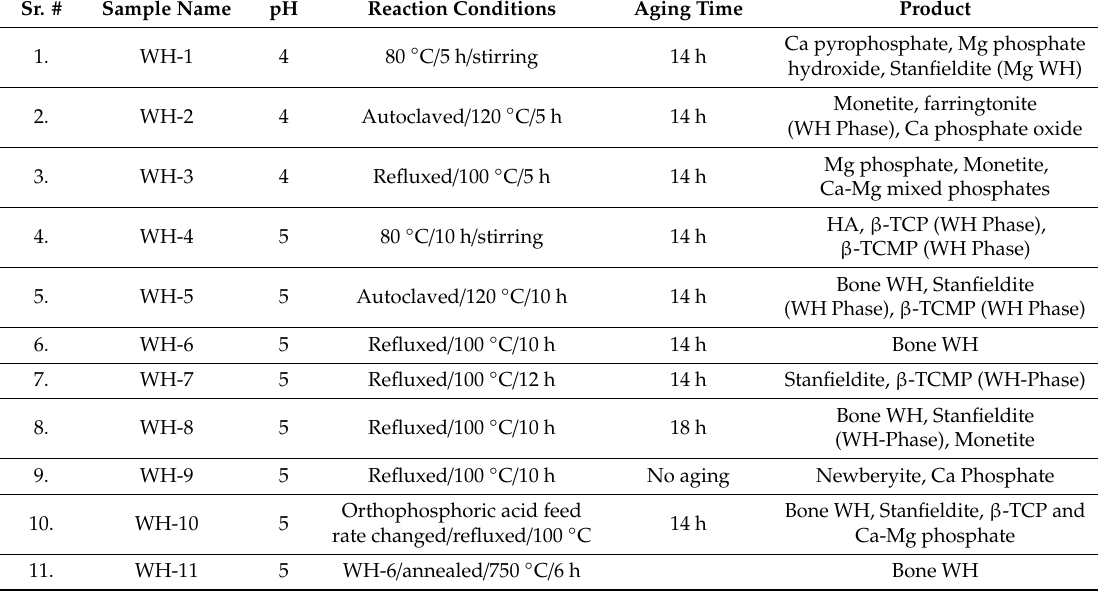
Table 1. E ff ect of various reaction parameters on whitlockite (WH) synthesis (WH-1 to WH-11). Sr.